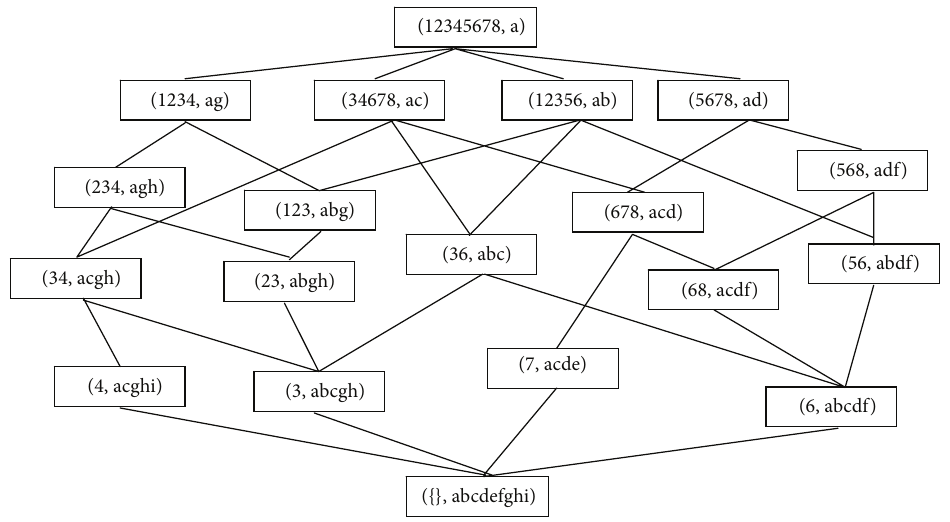
Figure 1: Concept lattice of the context “biology and water.” Table 2: A comparison between our method and [2] with respect to the number of concepts visited.